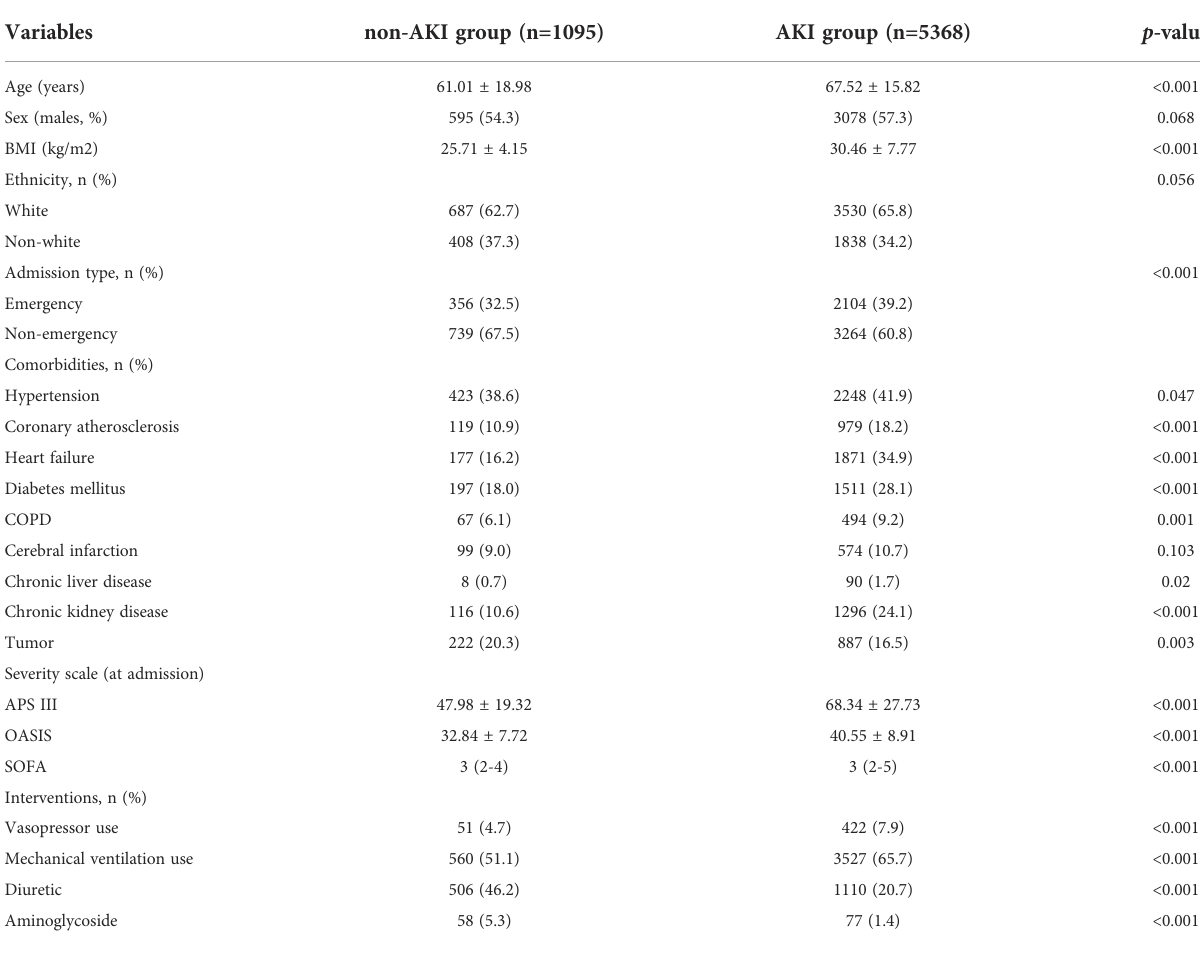
TABLE 2 Comparison between AKI group and non-AKI